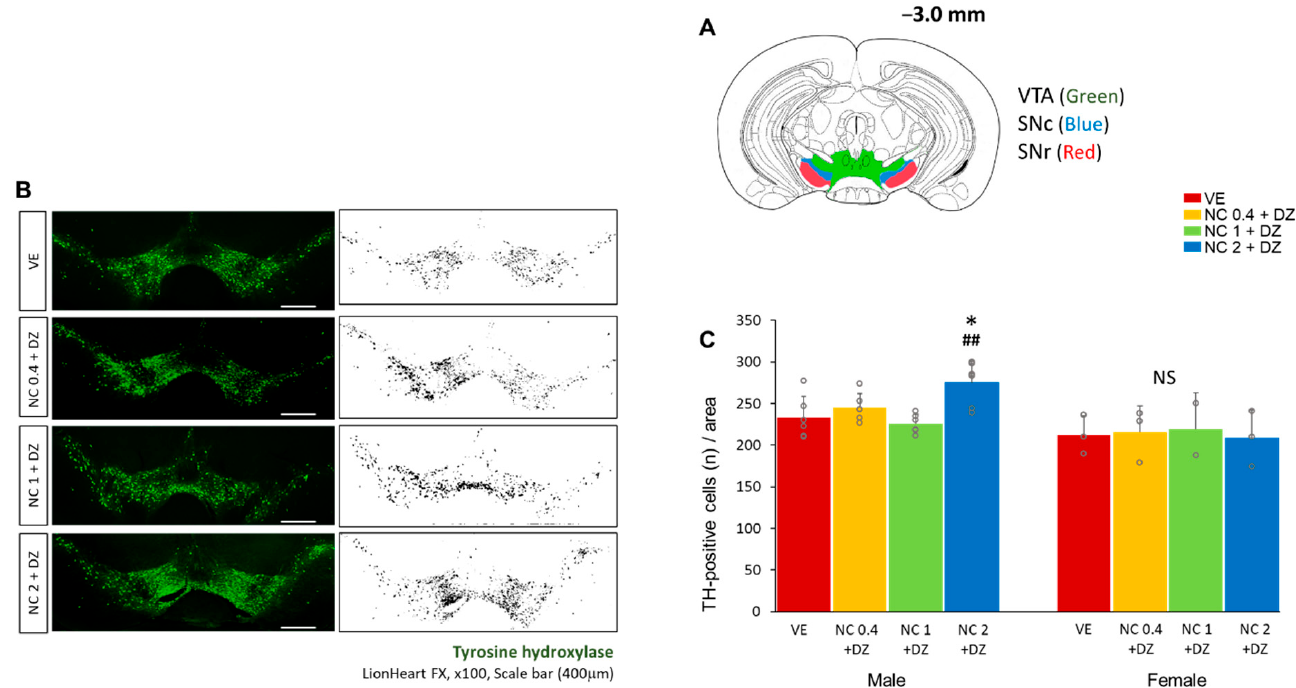
Figure 6. Co-exposure to nicotine and diazinon changed the number of dopaminergic neurons in male mice brain. Brain tissues from male mice offspring (n = 4 for male, n = 3 for female) were immunolabelled with anti-tyrosine hydroxylase (TH) antibody. ( A ), schematic images of the selected brain region, ventral tegmental area (VTA: green colored), substantia nigra pars compacta (SNc: blue colored), substantia nigra pars reticulata (SNr: red colored); ( B ), localization of Tyrosine hydroxylase (TH)-positive neurons in coronal brain section; images were converted to 8-bit grey-scale via NIH Image, scale bar, 400 µ m; ( C ), Quantification of B, the amount of TH-positive cells increased in the NC2 + DZ treated male group compared to vehicle and NC1 + DZ exposure group (* p < 0.05 vs. VE, ## p < 0.01 vs. NC1 + DZ, F 3,24 = 5.646 , p = 0.0057). No significance was detected among female groups. VE, vehicle-treated group; NC0.4 + DZ, 0.4 mg/kg nicotine and 0.18 mg/kg diazinon-treated group; NC1 + DZ, 1 mg/kg nicotine and 0.18 mg/kg diazinon-treated group; NC2 + DZ, 2 mg/kg nicotine and 0.18 mg/kg diazinon-treated group. Female staining data were not presented due to no statistical significance (Data are not shown). Data are presented as the means ± standard deviation. Statistical significance was determined by one-way ANOVA with the Tukey’s correction